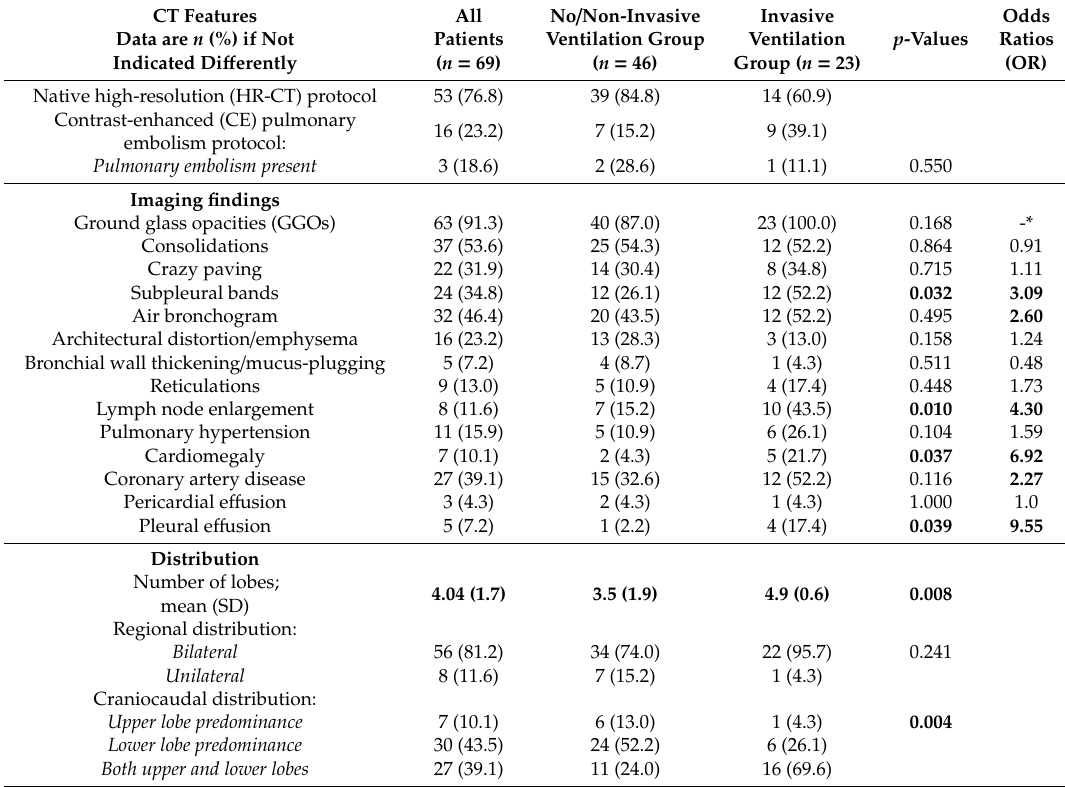
Table 2. Computed tomography (CT) and chest radiograph (CXR) imaging features of our study cohort. CT Features Data are n (%) if